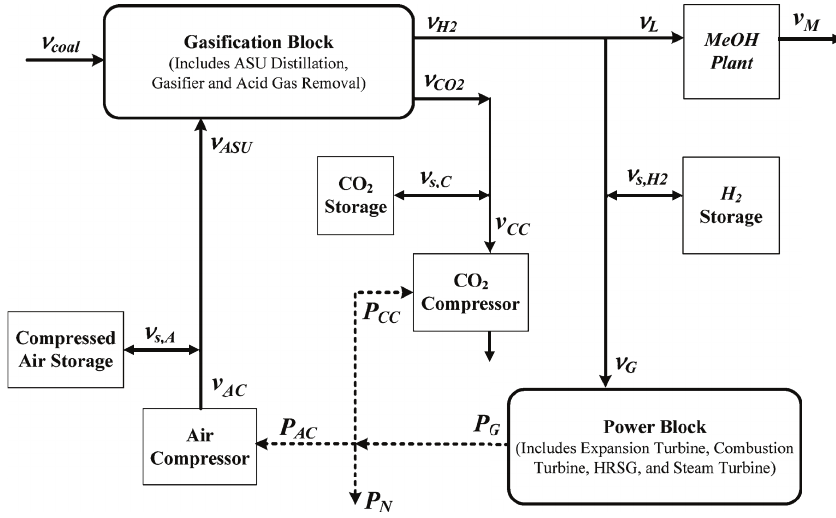
Figure 1. Simplified diagram of an IGCC power plant with equipment upgrades for power dispatch. ASU, Air Separation